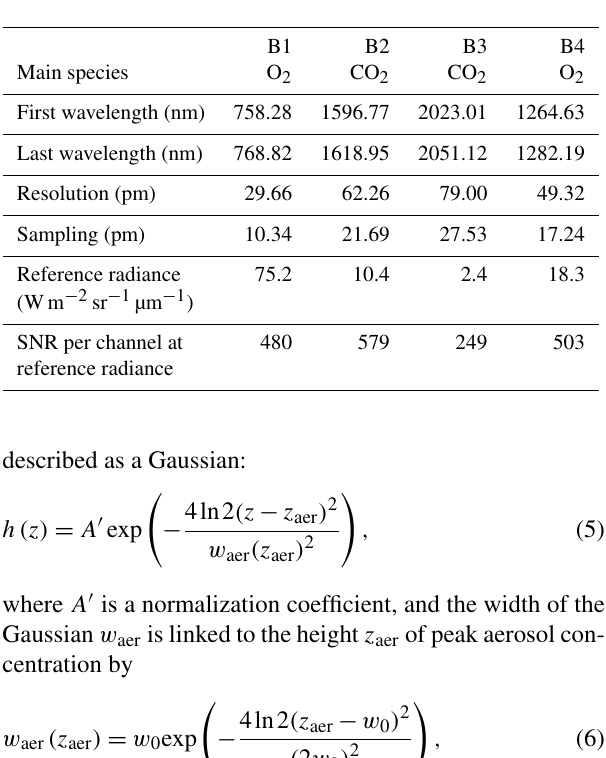
Table 1. Main characteristics of the four MicroCarb bands (B1, B2, B3,